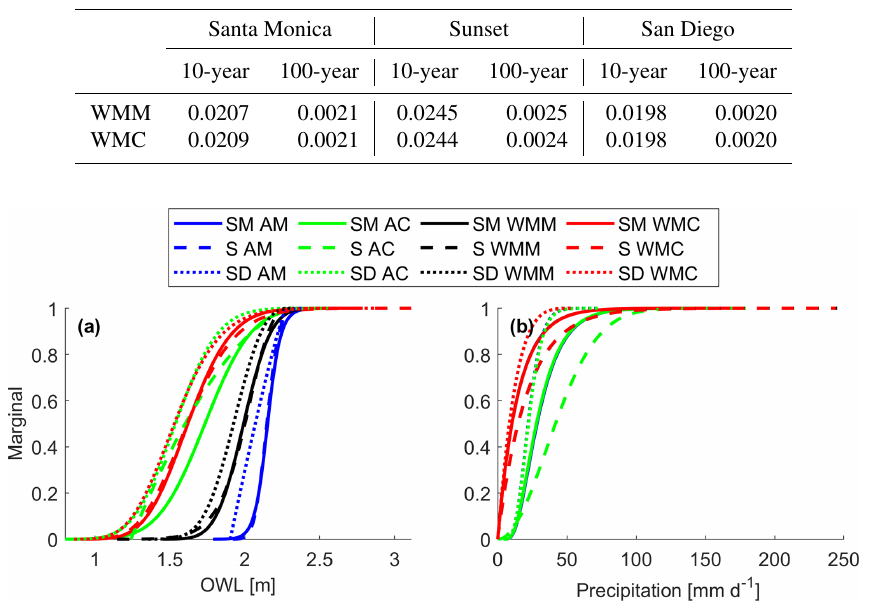
Figure 3. (a) OWL and (b) precipitation marginals for Santa Monica (SM; solid lines), Sunset (S; dashed lines), and San Diego (SD; dotted lines) using annual maximum (AM; blue), annual coinciding (AC; green), wet-season monthly maximum (WMM; black), and wet-season monthly coinciding (WMC; red) samplings.